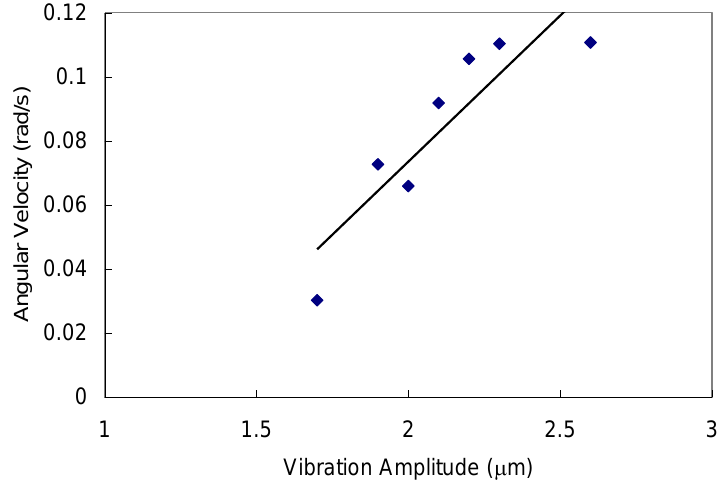
Figure 13. Angular velocity versus vibration amplitude at 1,090